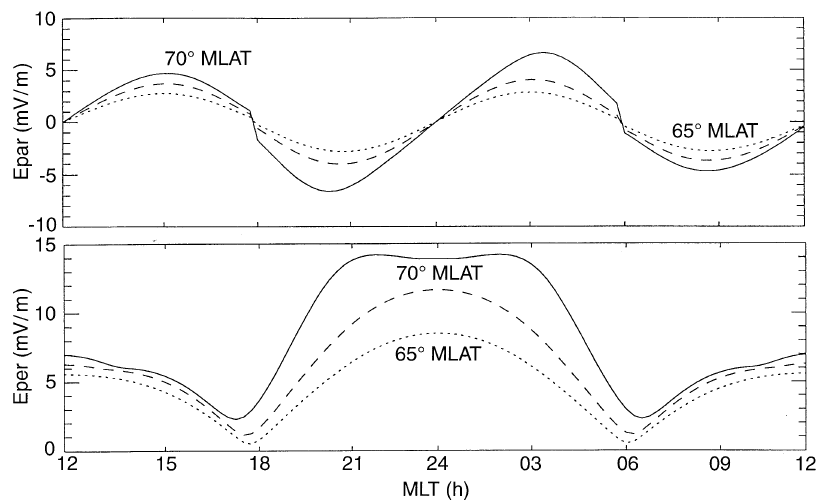
Fig. 3. The intensity of field-aligned and perpendicular components of the induced electric field is calculated along field lines at half-collapse ( t " t (cid:100) /2). The maximum value in the northern hemisphere is found and plotted versus local time; top -field-aligned, bottom - perpendicular component; 65 ° ( dotted ), 68 ° ( dashed ), and 70 ° ( continuous ) MLAT field lines are considered. In the sourthern hemisphere the polarity of the field-aligned component is reversed; in the 18 — 24-MLT sector it is downward the magnetic